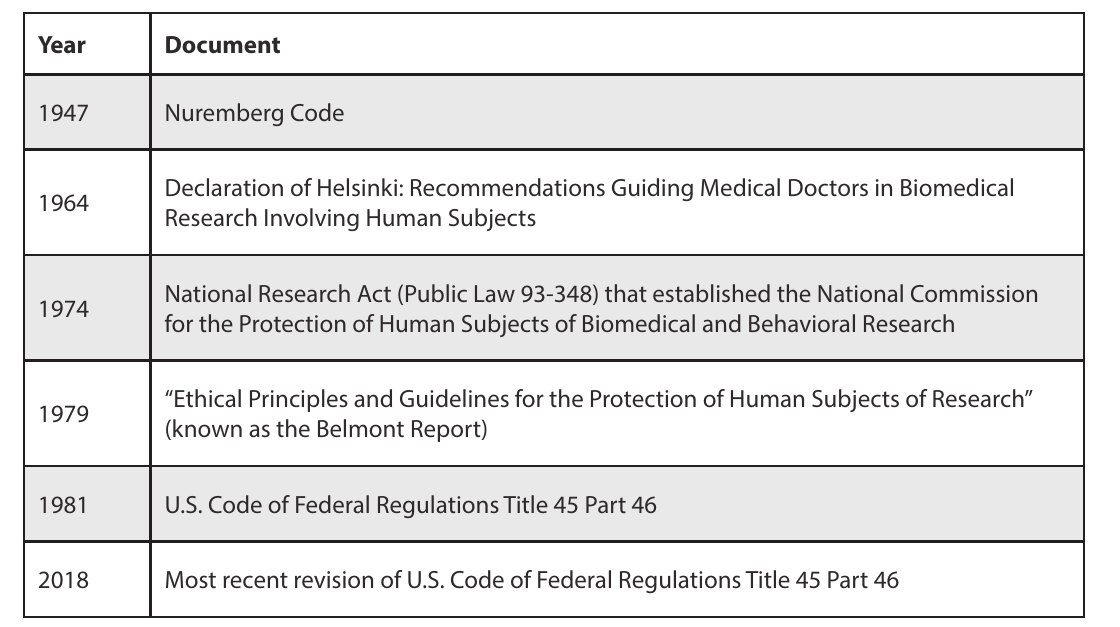
Table 1 : Foundational documents leading to the Common